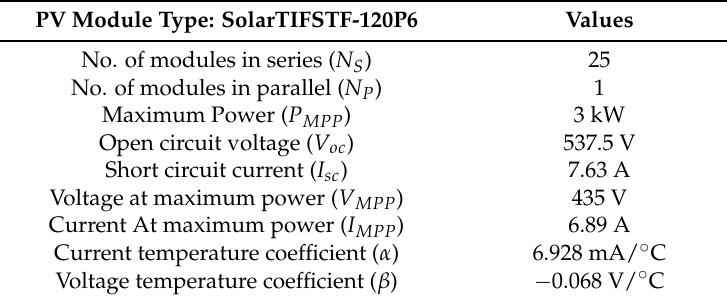
Table 2. PV module characteristics.